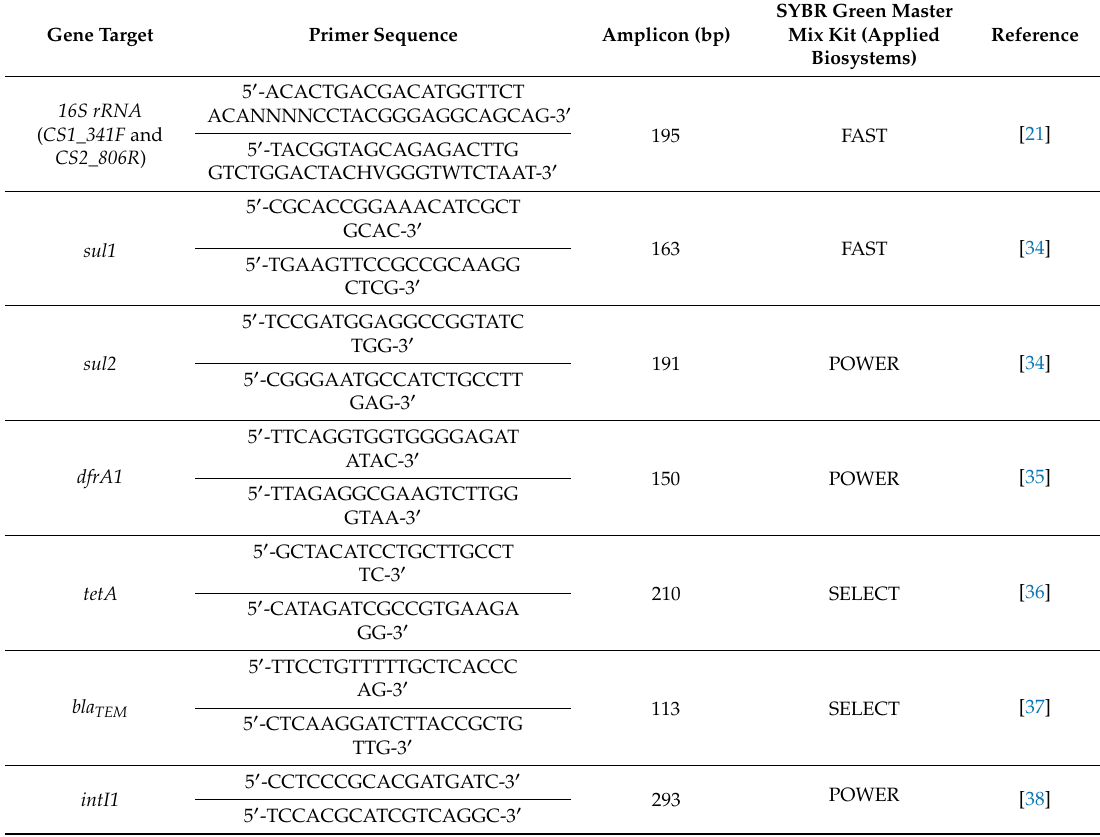
Table 1. qPCR primers and conditions used in this